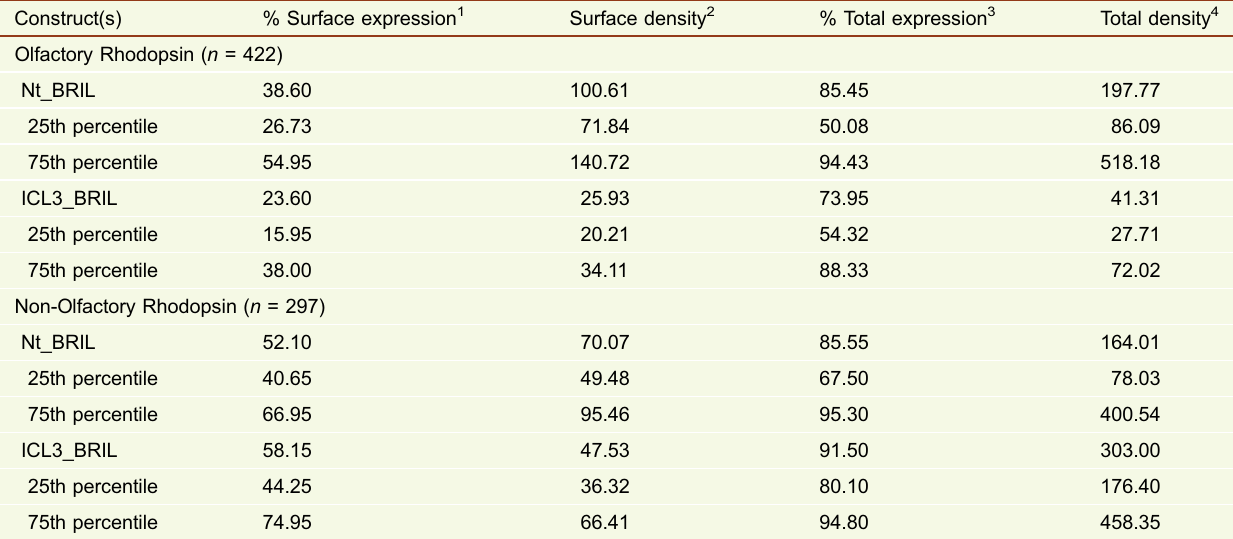
1 Surface expression: The ratio of all the cells expressing the target receptors on the membrane to total cells. 2 Surface density: The ratio of all the fl uorescence of membrane proteins to total cells. 3 Total expression: The ratio of cells expressing the target receptors to total cells. 4 Total density: The ratio of all the fl uorescence to